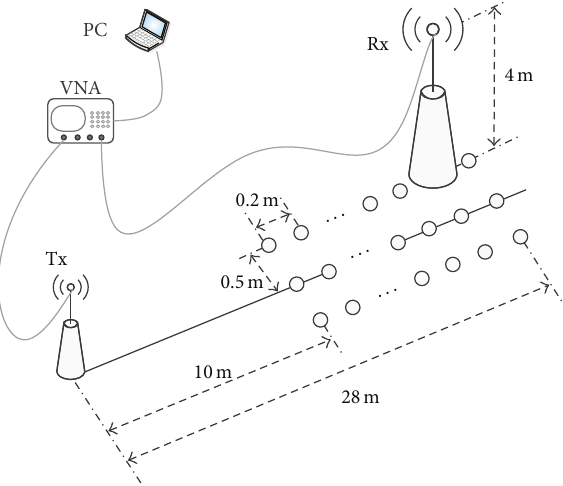
Figure 2: Diagram of the measurement